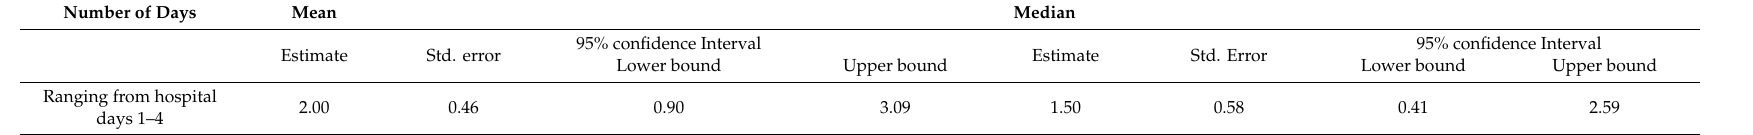
Table 2. Showing means and medians for time interval between presentation and diagnosis (in